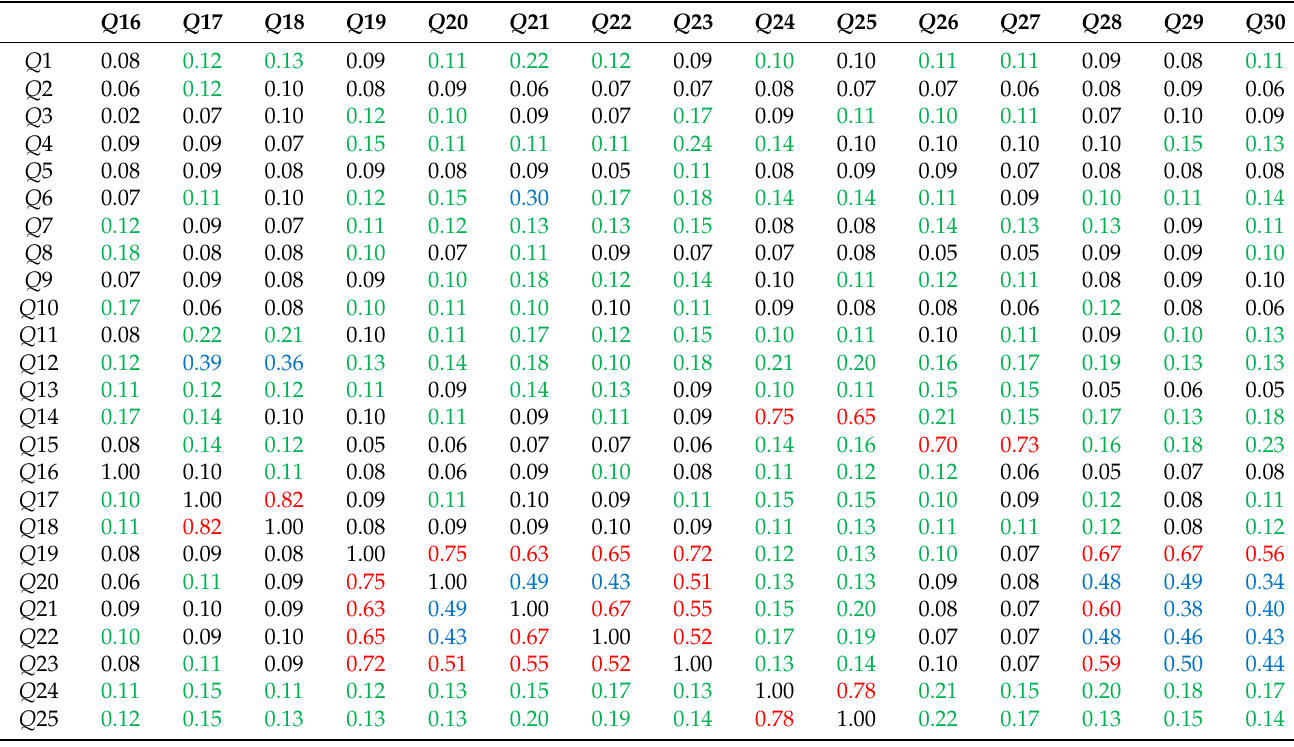
Table A3. The values of the Cramer’s V coefficient for questions Q 16– Q 30 (questions numbers ( Q ) according to the Appendix